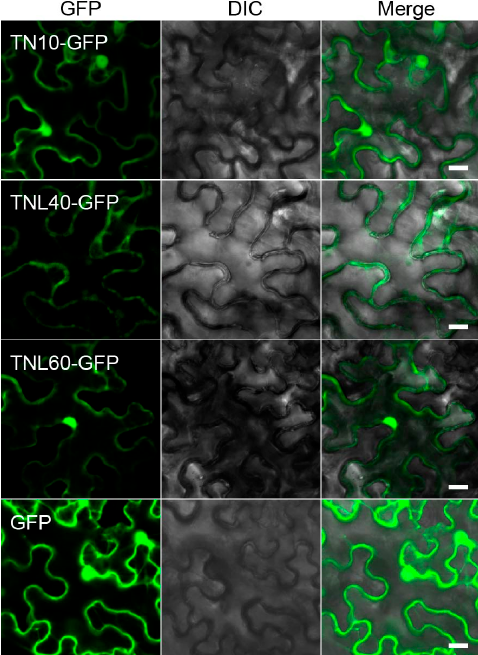
Figure 3. Subcellular localizations of TN10, TNL40, and TNL60. Subcellular localization of TN10, TNL40, and TNL60 in N. benthamiana leaves. The TN10-GFP, TNL40-GFP, and TNL60-GFP were transiently expressed in 4-week-old N.benthamiana leaves. GFP fluorescence was visualized 48 h after transformation. The GFP alone protein was used as a control. Bar = 20 μ m.